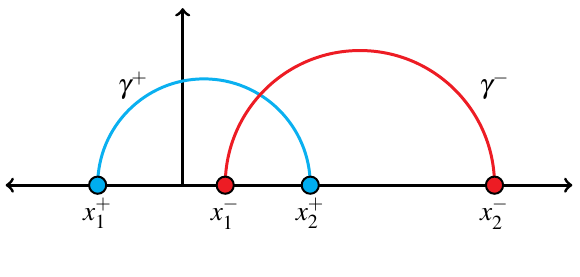
Figure 1: Graphical depiction of the proof of Theorem